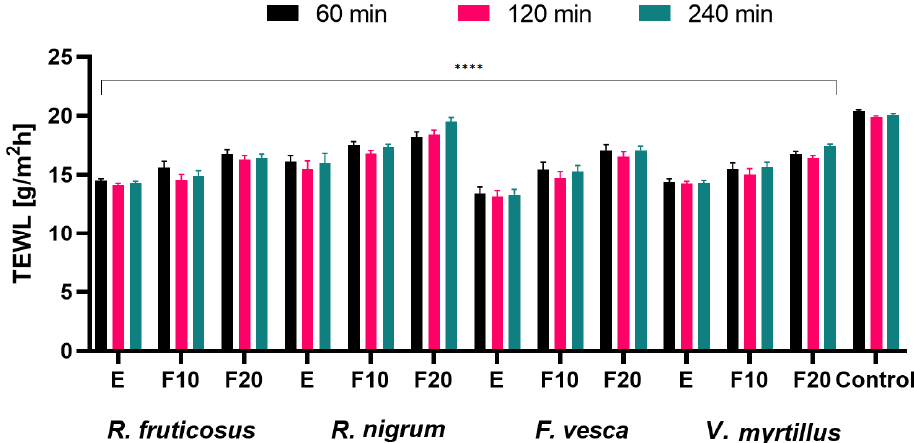
Figure 10. The influence of R. fruticosus L., R. nigrum L., F. vesca L., V. myrtillus L. extract and kombucha ferments (at concentration of 300 µ g/mL) on transepidermal water loss (TEWL). Data are the mean ± SD of five independent measurements. **** p < 0.0001 versus the control.